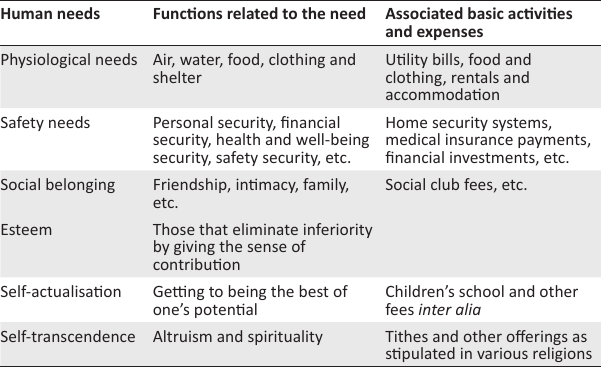
TABLE 1: Day to day expenses associated with human